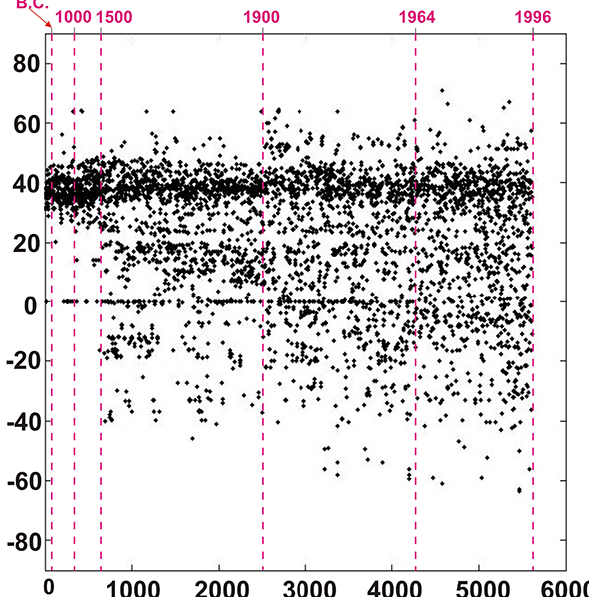
Fig. 5. The latitudinal distribution of strong historical earth- quakes (from catalog of the significant worldwide earthquakes NEIC/USGS from 2150BC until 1995AD). The serial number of the time-ordered seismic events in the catalog is given along the bottom equidistant horizontal axis (black labels). The years of earth- quake occurrences are given by magenta color labels on the upper nonuniform time scale (magenta grid vertical lines). The latitude of earthquake is given along ordinate